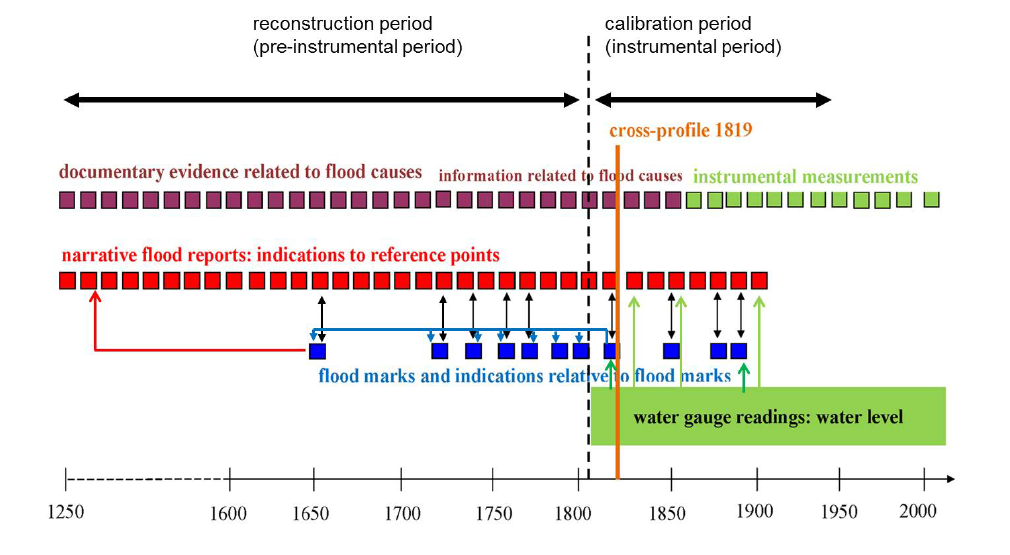
Figure 1. Qualitative calibration: assigning gauges to pre-instrumental “flood information systems” (Wetter et al., 2011).